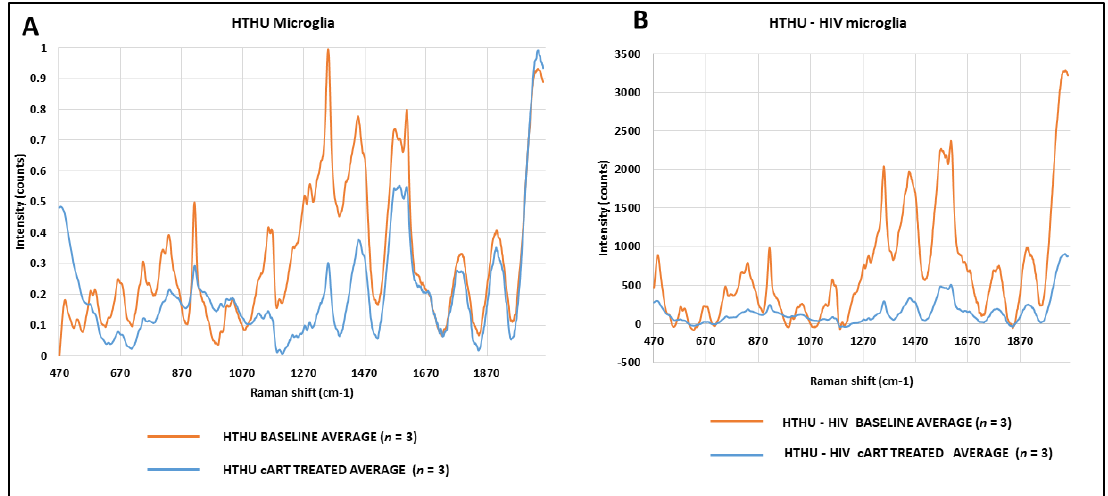
Figure 7. Raman spectra of HTHU and HTHU/HIV microglia treated with cART. A minimum of 3–4 Raman hyperspectral datasets will be obtained per sample, following which, the fluorescence background signal will be subtracted from the Raman spectra at each pixel in the image by a modified polyfit fluorescence removal technique using the HORIBA software. ( A ) HTHU Microglia; ( B ) HTHU—HIV microglia